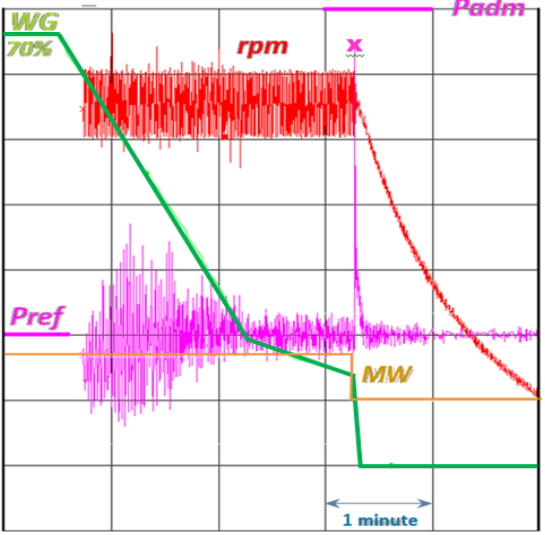
Figure 7. Overpressure peak from speed-no-load measured in 2016 in hydropower plant equipped with high-head Francis turbines [88].